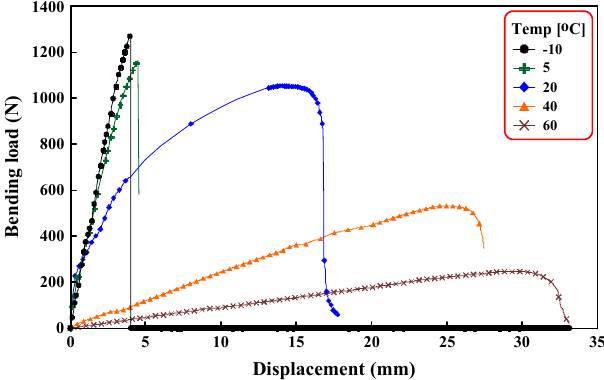
Figure 7. Load–displacement curves of beams tested for flexural strength.